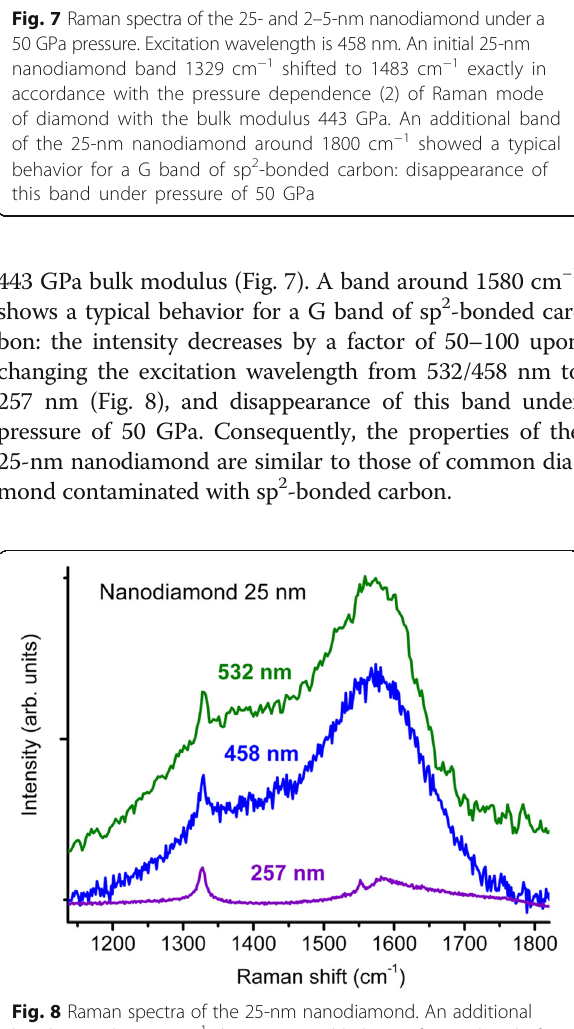
Fig. 6 Dependence of the 1600 cm − 1 relative Raman band shift upon pressure. Solid circles with crosses indicate a pressure increase; the ones without crosses belongs to a pressure decrease. A dash line reproduces dependences from Ref. [25] for diamond-like carbon DLC (in the Ref. [25] one marked as a-C) and glassy carbon i-C